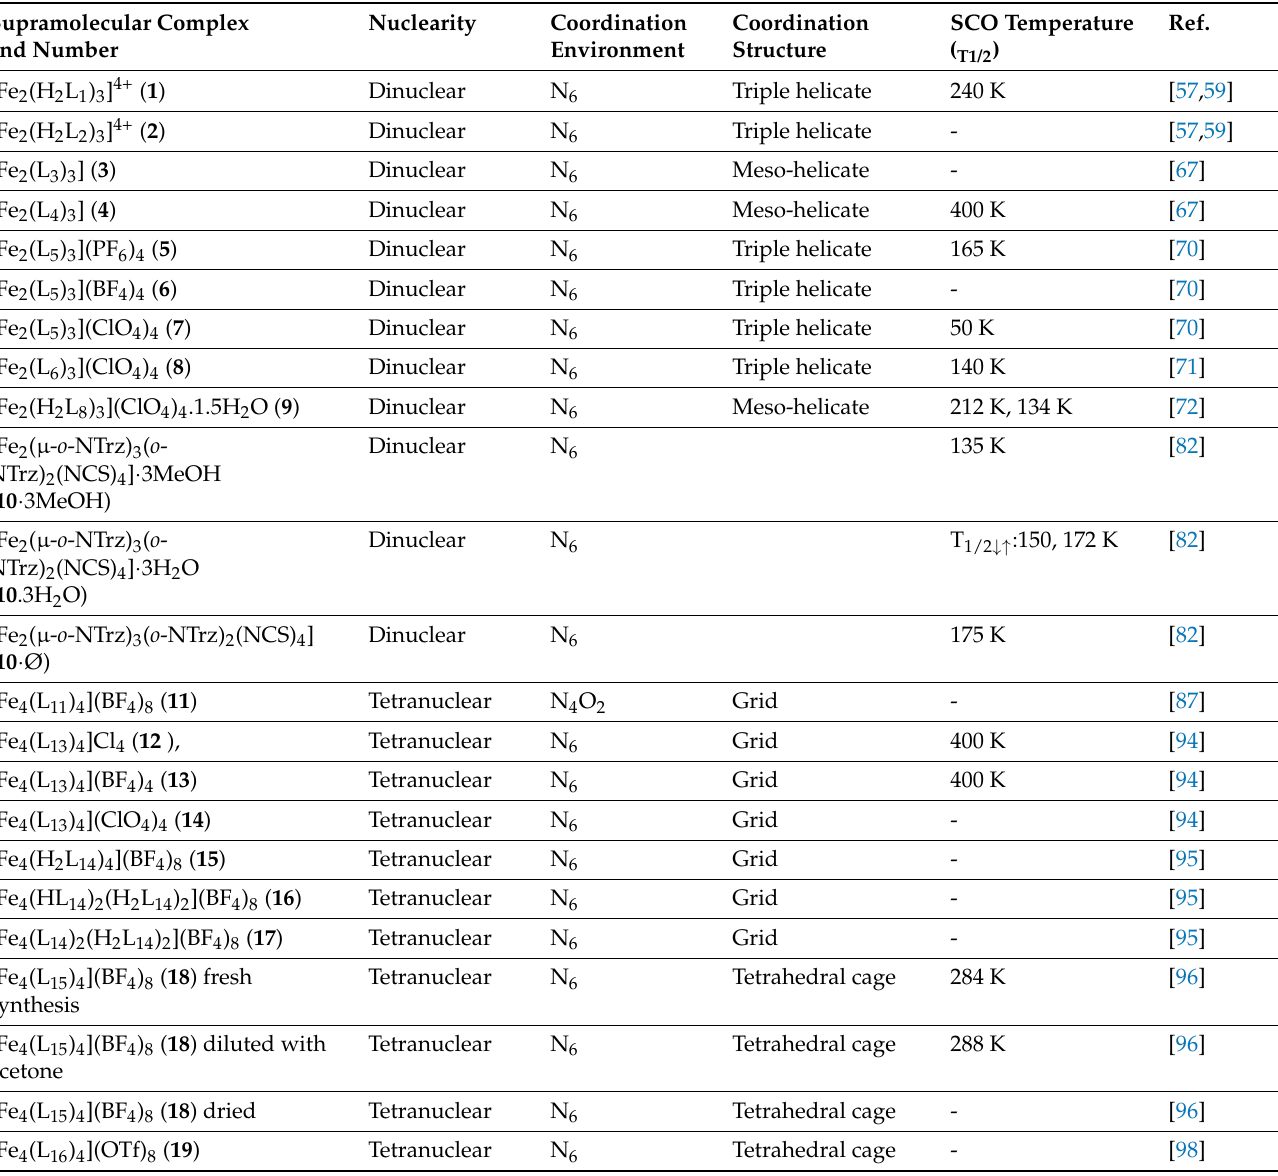
Table 2. Coordination environments and SCO properties of iron(II) supramolecular Schiff base complexes. Nuclearity Coordination Coordination SCO Environment Structure